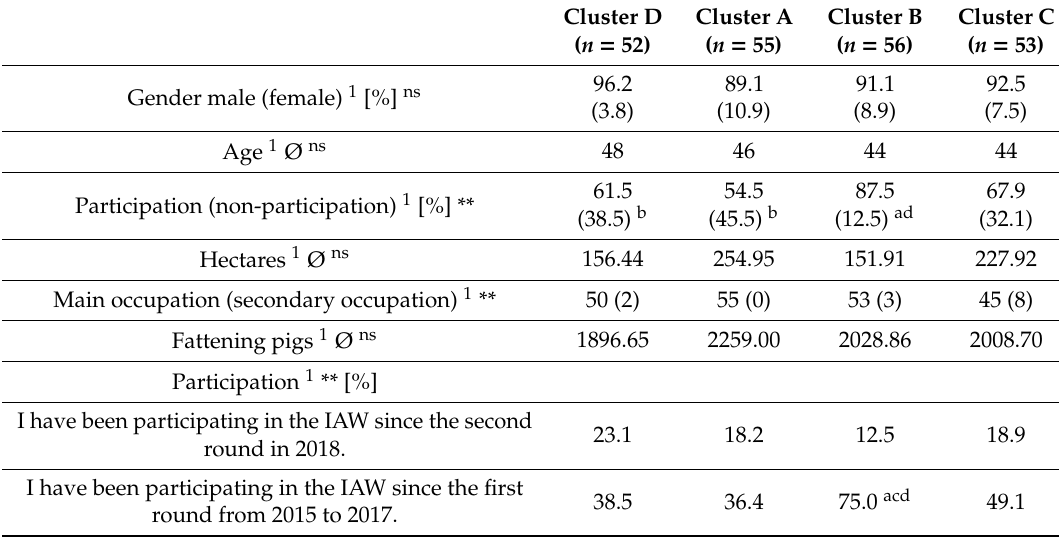
Table 3. Sociodemographic and farm characteristics of the